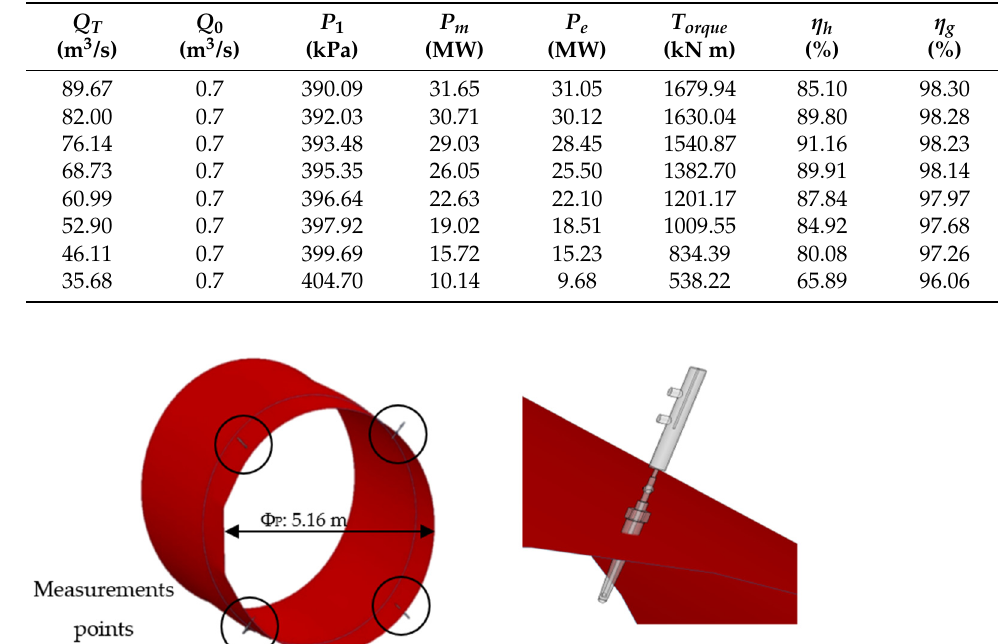
Table 1. Parameters of the turbine on study [18,19].